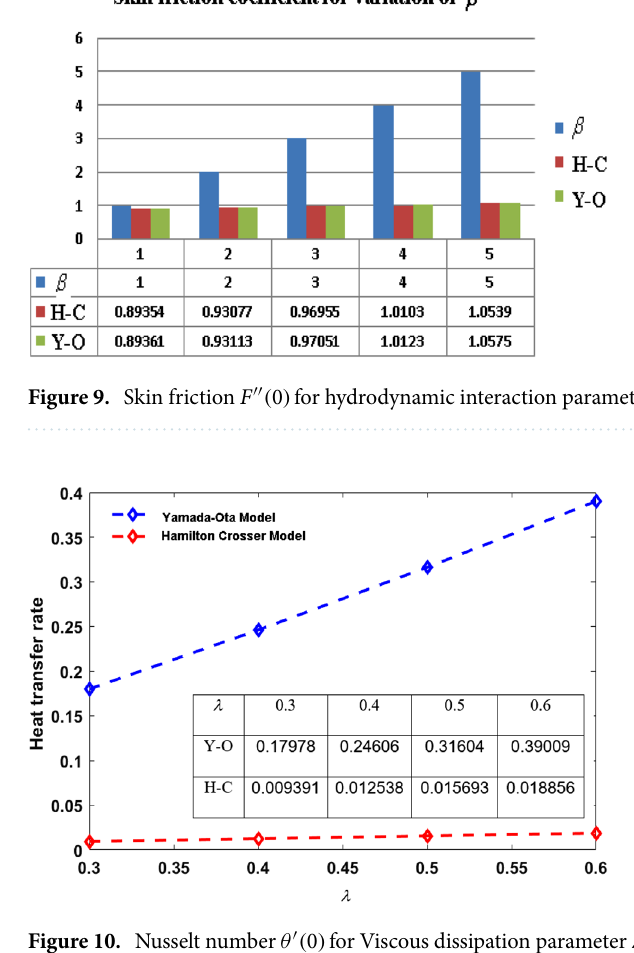
Figure 10. Nusselt number θ ′ ( 0 ) for Viscous dissipation parameter (cid:31)